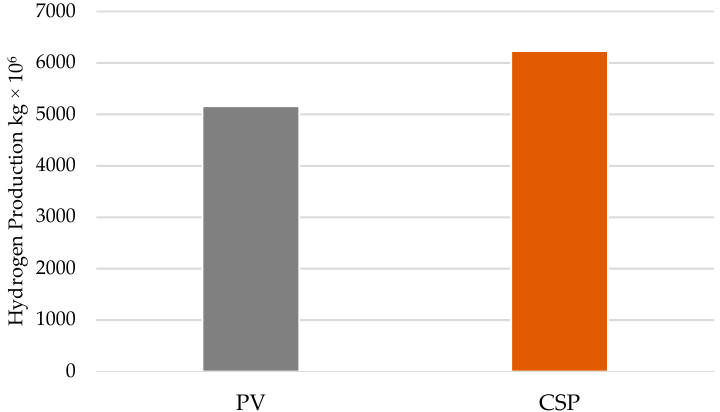
Figure 5. Hydrogen levels produced from PV and CSP comparison, in plants at the same location as solar energy sites pathway.